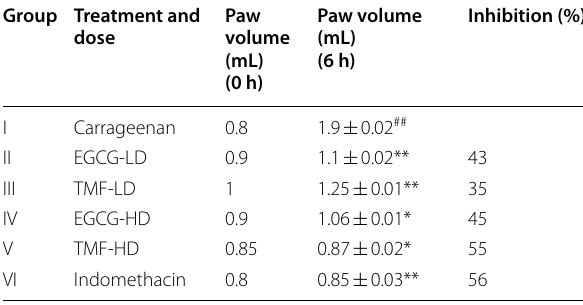
Table 2 Carrageenan induced acute inflammatory model in WS rats